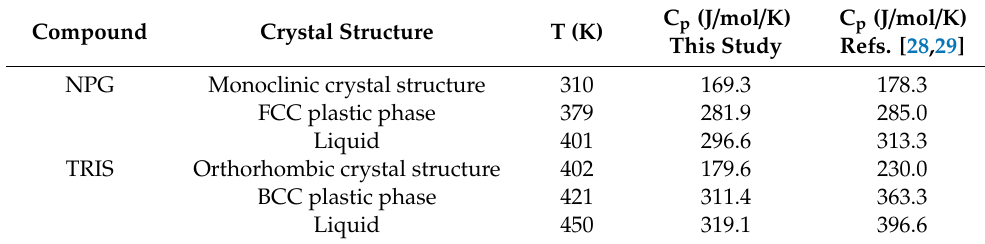
Table 2. Specific heat value (C p ) for temperatures characteristic of the low temperature ordered phase, the plastic phase and the liquid of NPG and